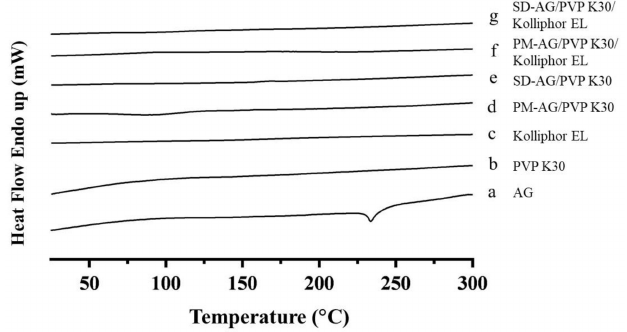
Figure 2. Di ff erential scanning calorimetry spectrum of: ( a ) andrographolide (AG); ( b ) PVP K30; ( c ) Kolliphor EL; ( d ) physical mixture (PM)-AG / PVP K30 (1:7, w / w ); ( e ) solid dispersion (SD)-AG / PVP K30 (1:7, w / w); ( f ) PM-AG / PVP K30 / Kolliphor EL (1:7:1, w / w / w ); and (g) SD-AG / PVP K30 / Kolliphor EL (1:7:1, w / w / w ).